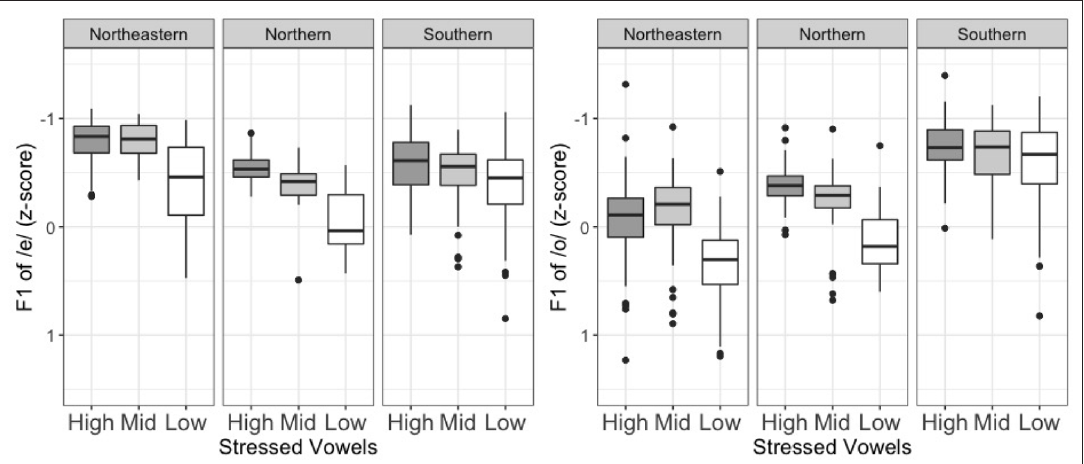
Figure 3: F1 of pretonic /e/ (left panel) and /o/ (right panel) as a function of the three dialects and the three stressed vowel